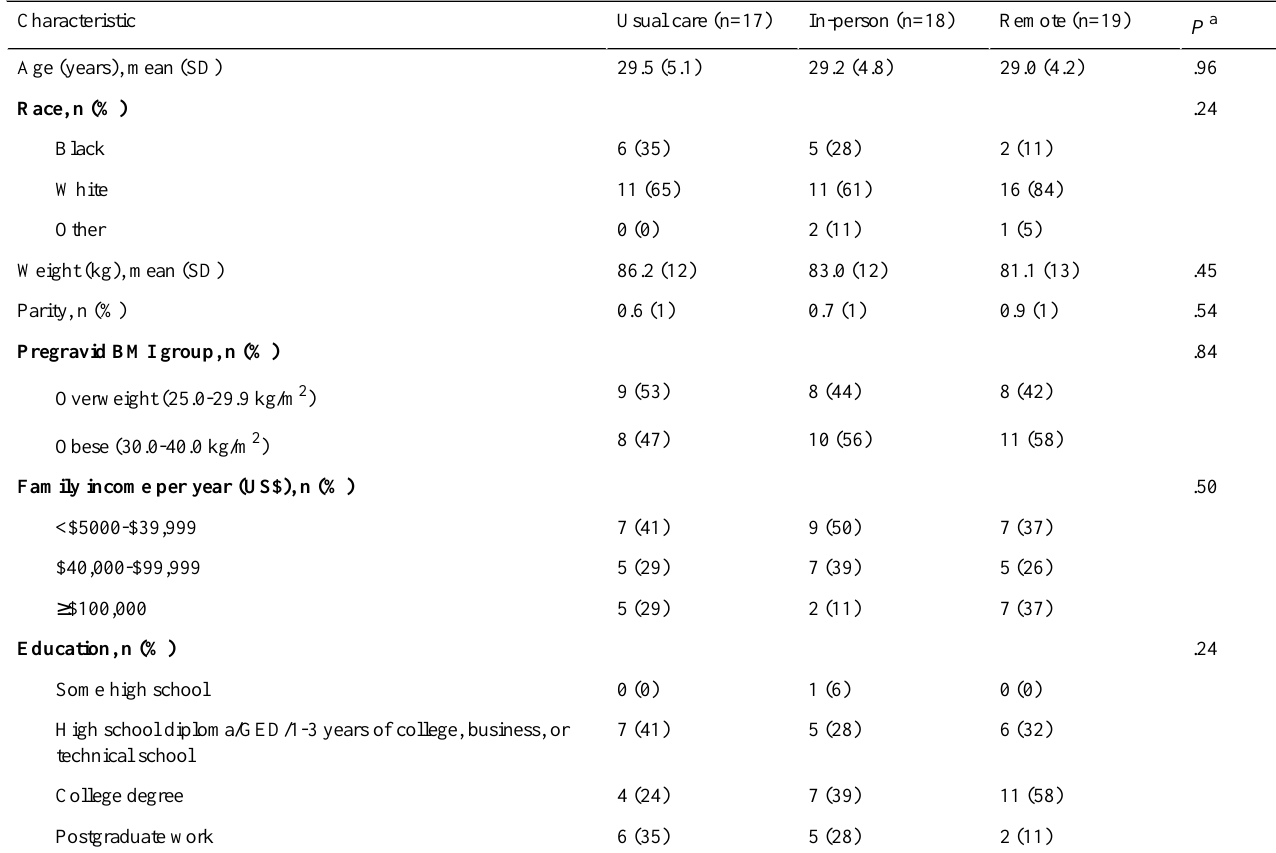
Table 1. Baseline characteristics by treatment group